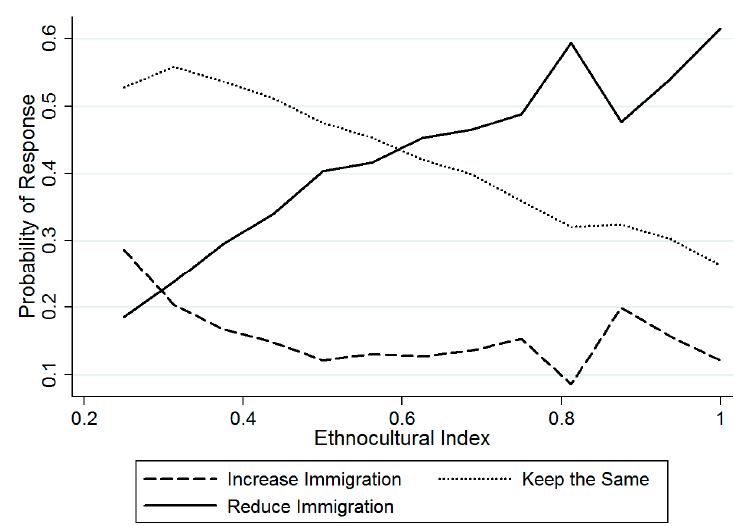
Figure 4. Predicted probability of response based on ethnocultural index score.